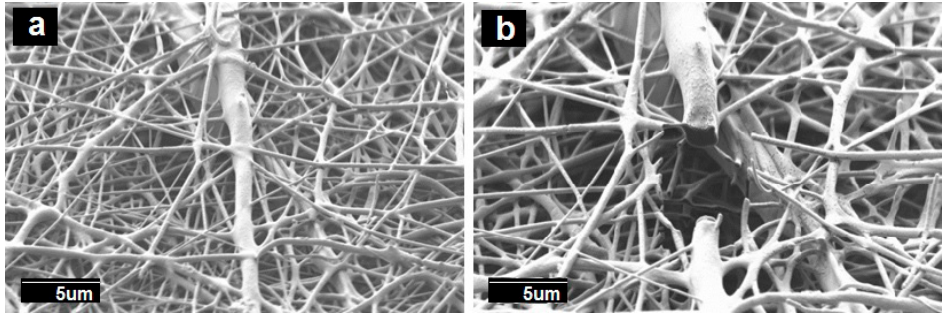
Figure 7. SEM images of the PHB sample. ( a ) Overview of PHB nanofibers, ( b ) PHB fibers after FIB sectioning.